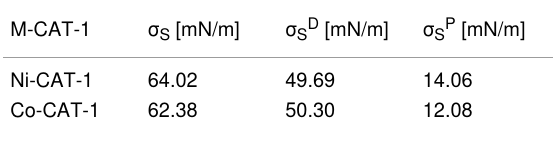
Table 1: Surface energy ( σ S ) and the respective dispersive ( σ SD ) and polar ( σ SP ) components estimated for Ni- and Co-CAT-1 pellet sam- ples.